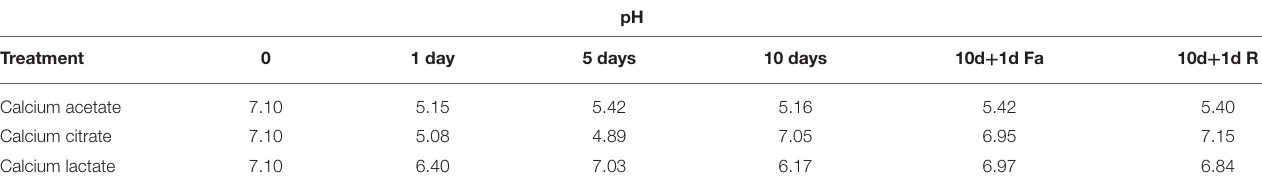
TABLE 3B | pH values during time course treatment of JFSW in brines with calcium acetate, citrate, and lactate at 1, 5, and 10 days.